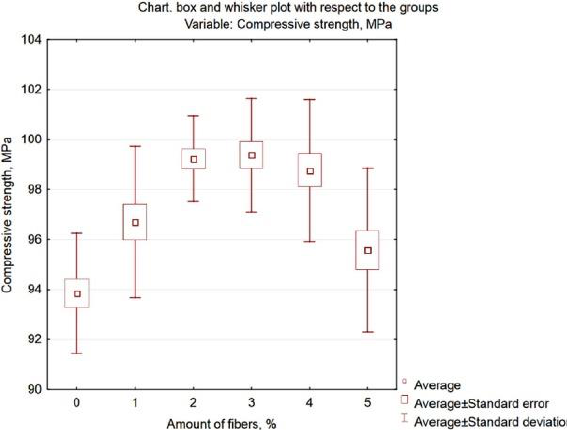
Figure 12. Box and whisker plot of compressive strength related to fibre content.